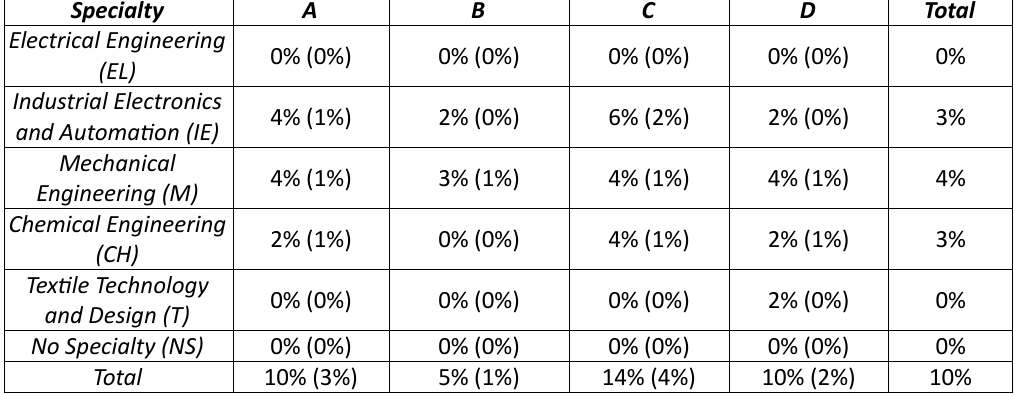
Table 6. Academic year 2012/13 - Percentages of grades equal to or beter than 8/10, by group and specialty (the percentage of the total is indicated in parentheses)